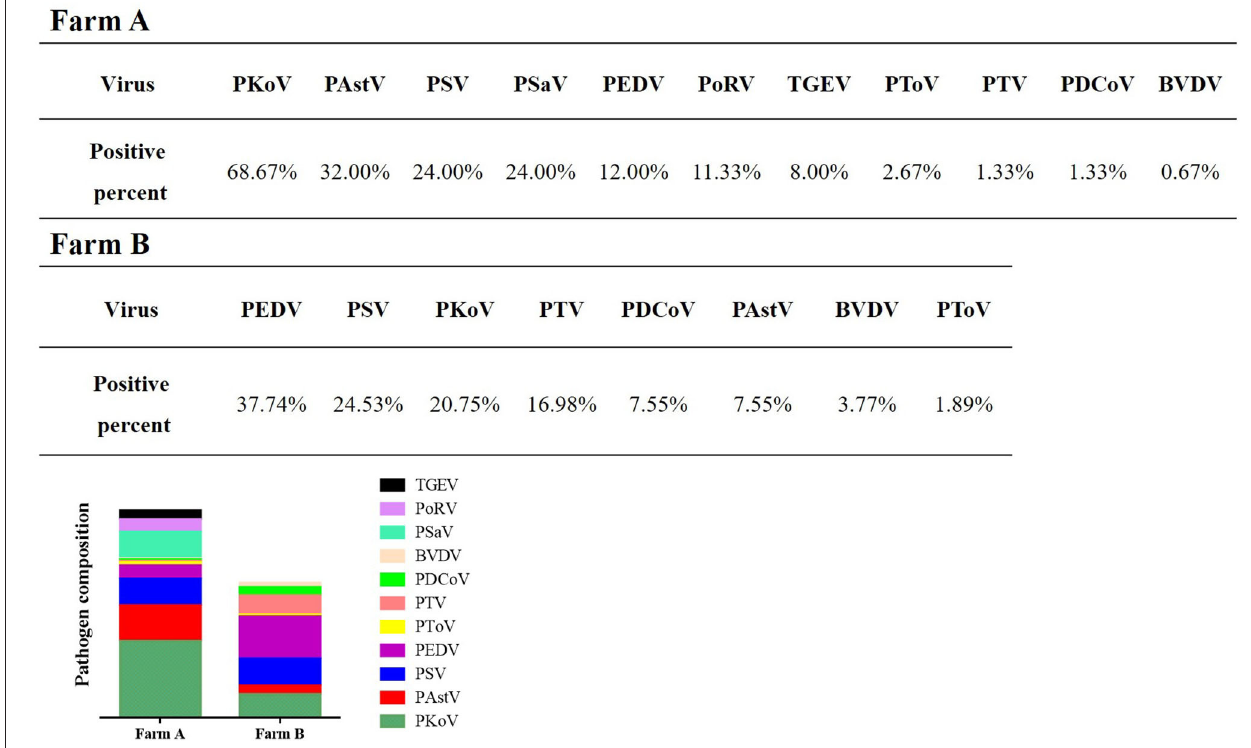
FIGURE 5 | Detection of enteric viruses in different farms. The composition of enteric pathogens among different farms was